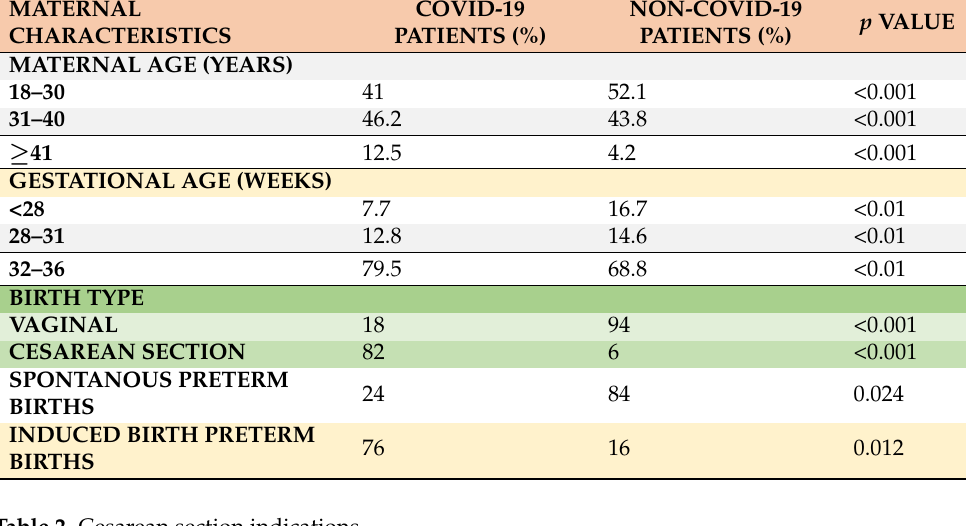
Table 1. Clinical characteristics of the patients.